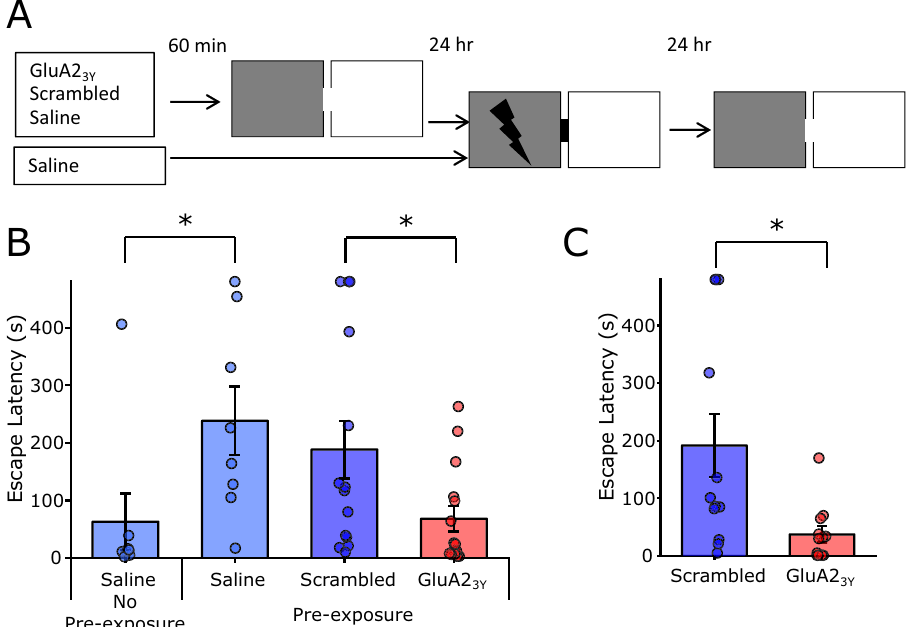
Fig. 5 Blocking AMPA receptor endocytosis impairs contextual pre-exposure facilitation of inhibitory avoidance. A 60-min prior to contextual pre- exposure (8-min free exploration of both chambers), rats were administered GluA2 3Y peptide ( n = 15;2.25 μ mol/kg IV), Scrambled control ( n = 14), or saline vehicle ( n = 8). A fourth group was only administered saline without contextual pre-exposure ( n = 8). 24 h later rats were conditioned by direct placement into the dark compartment followed by immediate shock (2 × 0.4 mA, 0.5 s shock for IV experiment, 2 × 0.55 mA, 0.5 s shock for IC experiment) and removal. 24 h after training, rats were place in the light compartment and escape latency to the dark compartment was measured. B Saline treated rats with no contextual pre-exposure ( n = 8) show poor memory relative to pre-exposed rats ( n = 8). Systemic GluA2 3Y ( n = 15) administered during pre-exposure impaired inhibitory avoidance conditioning relative to a Scrambled control ( n = 14). C Local microinjection of GluA2 3Y ( n = 12; 45 pmol/ μ l, 2.5 μ l/hemisphere IC) in the dorsal hippocampus similarly impaired inhibitory avoidance conditioning relative to Scrambled control ( n = 12). * Indicates p < 0.05 pairwise comparison. Error bars represent ±